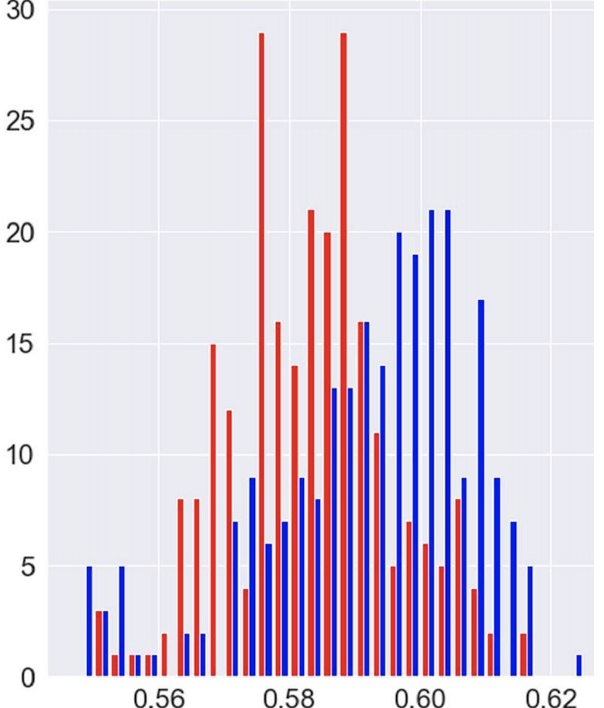
Figure 17. Inferred Hurst index histograms for 250 non-compressed (red) and 250 compressed (blue)